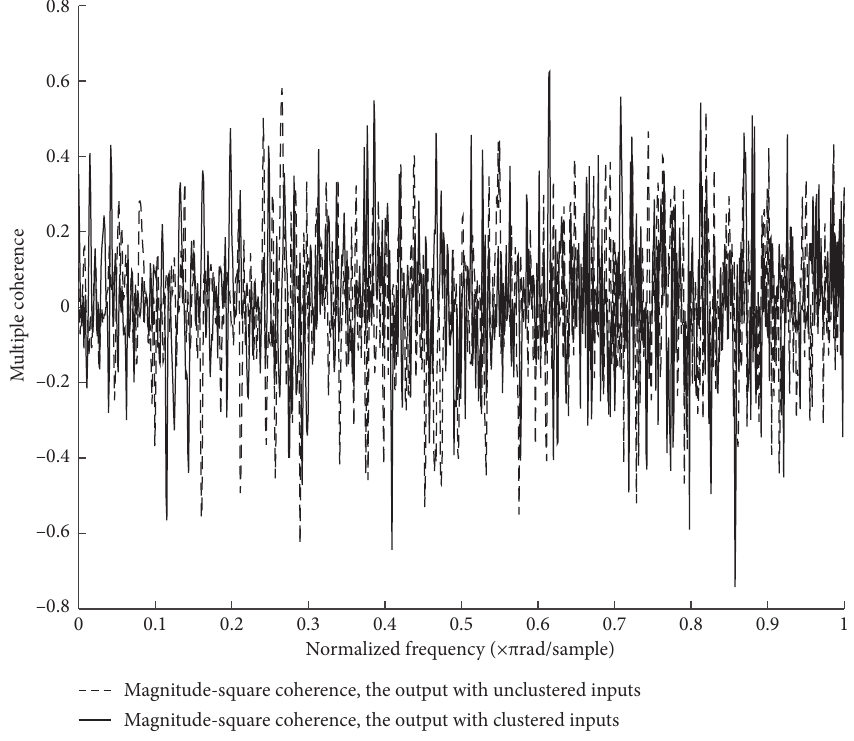
Figure 6: MSC of clustered and unclustered inputs with the system output y for noise variance of σ 2 � 0 . 40 2 .